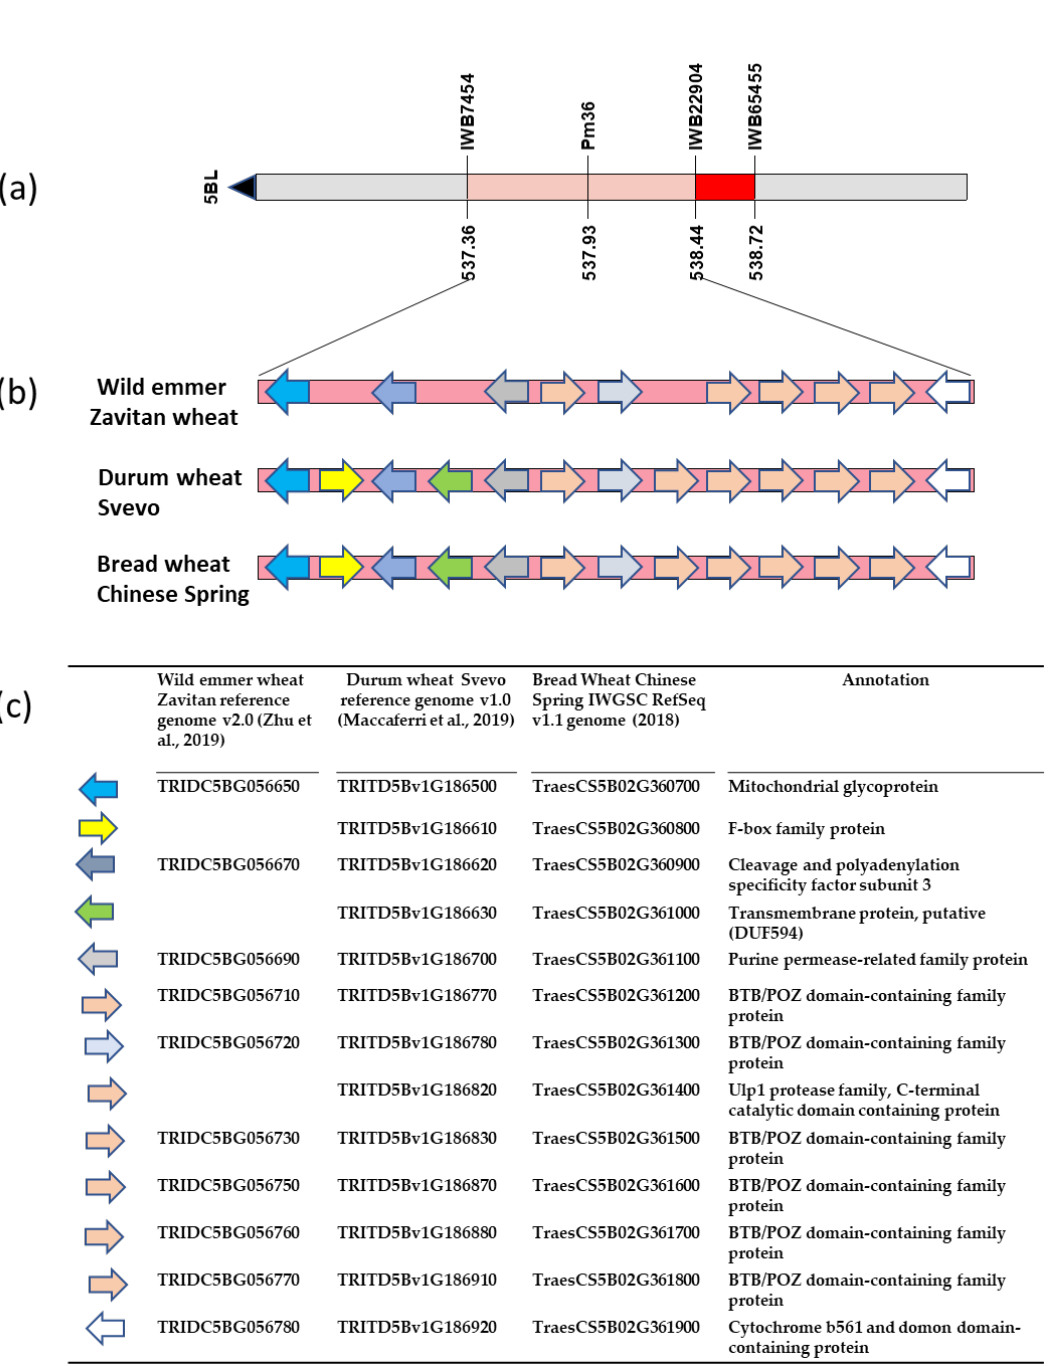
Figure 4. Fine mapping and candidate genes of Pm36 . ( a ) High-density map positioned Pm36 within a 1.08 Mb physical interval in the durum wheat Svevo reference genome [45]. Black arrow indicates direction of the centromere; ( b ) Micro-collinearity of the genomic region of Pm36 between the wild emmer Zavitan [46], durum wheat Svevo [45] and bread wheat Chinese Spring genomes [48]. Arrows represent the annotated genes in each species and their direction indicates which strand they are located on; ( c ) Genes ’ ID and their annotated functions in the emmer, durum and bread wheat genomes.